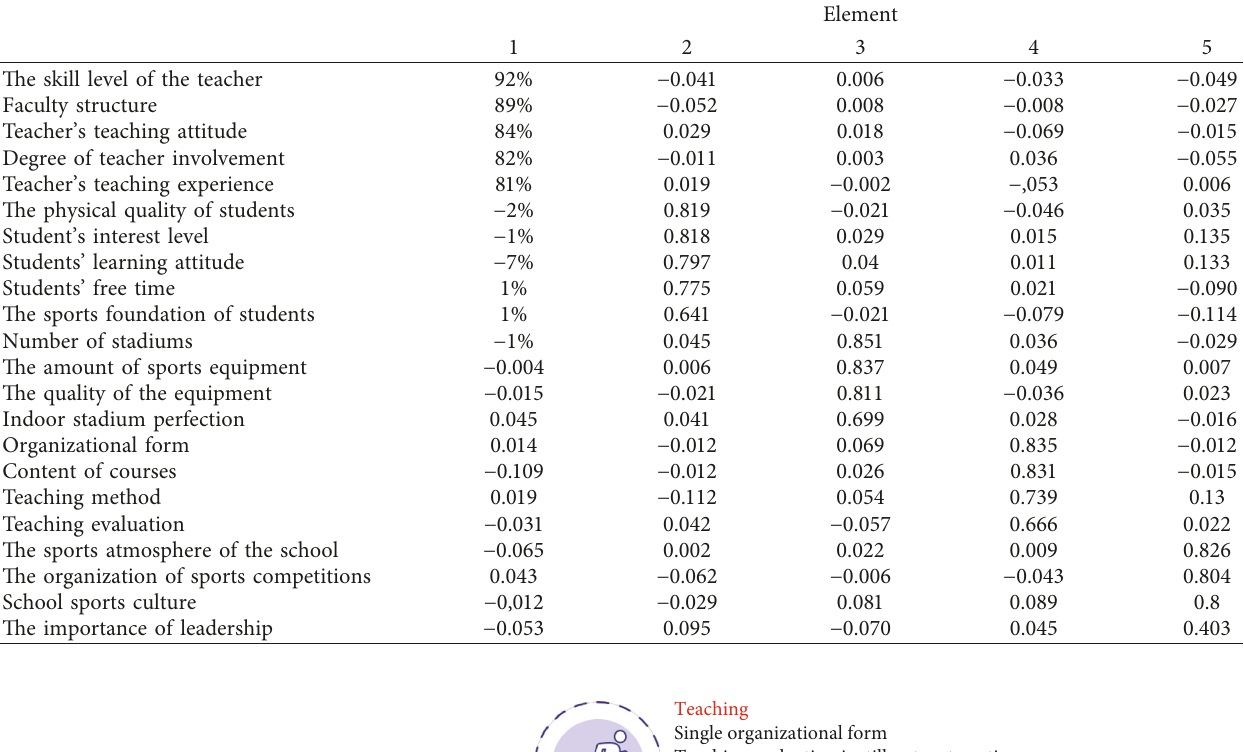
Table 16: Rotating component matrix.